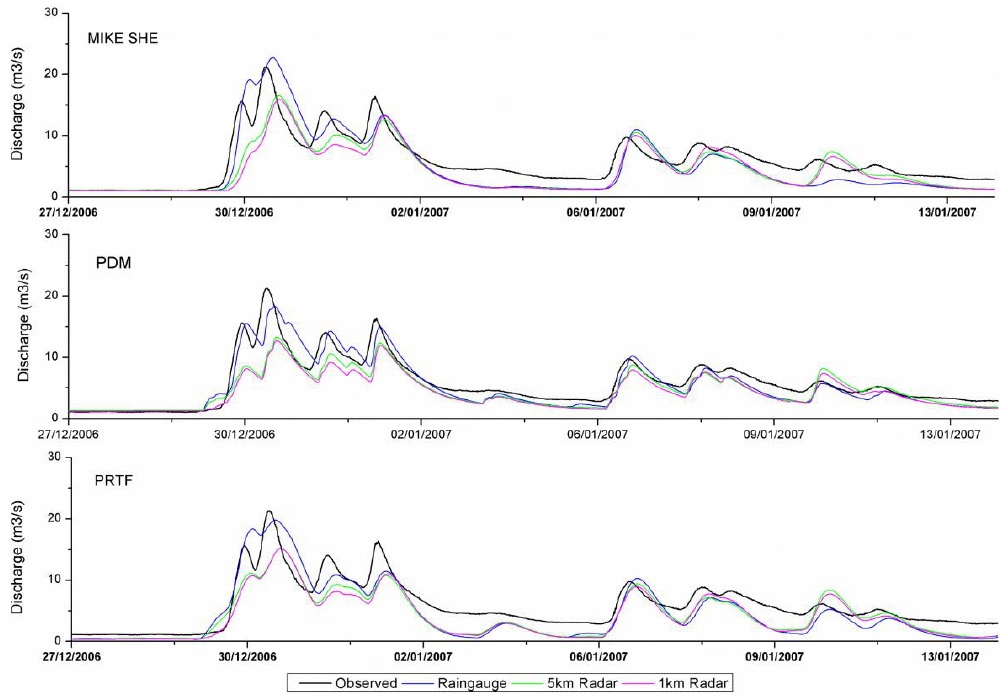
Figure 8. Model simulations for evaluation period A using raingauge and radar 750